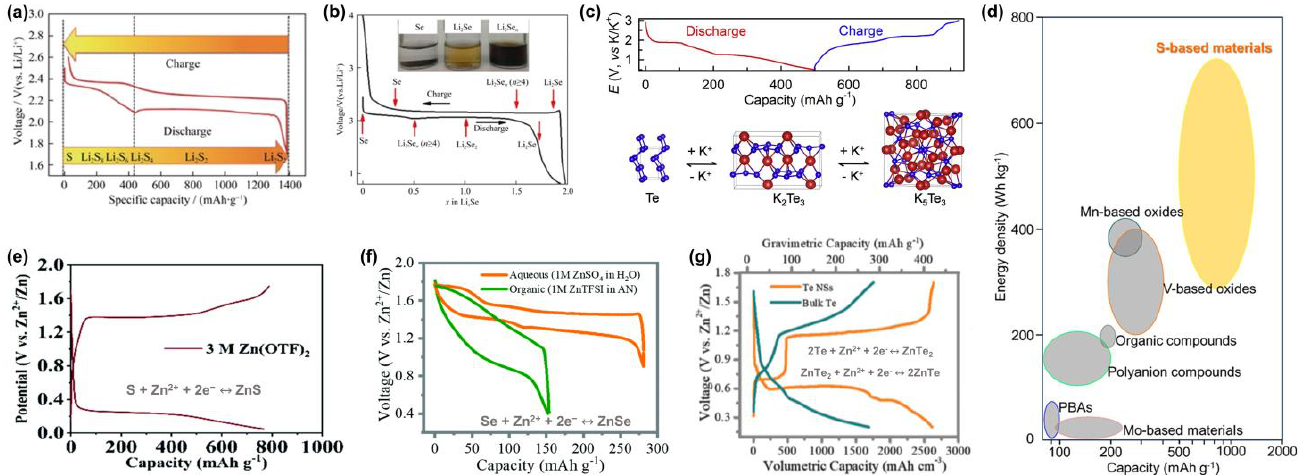
Figure 1. Voltage profiles and phase evolutions during charging/discharging of representative AMCBs: ( a ) Li-S batteries, ( b ) Li-Se batteries (reproduced with permission from Ref. [22]. Copyright 2017 The Nonferrous Metals Society of China and Springer-Verlag), and ( c ) K-Te batteries (reproduced with permission from Ref. [23]. Copyright 2020 Elsevier). ( d ) Comparison of capacities and energy densities of different cathodes in AZMBs (reproduced with permission from Ref. [61]. Copyright 2021, American Chemical Society). Voltage profiles during charging/discharging of representative AZCBs: ( e ) AZSBs (reproduced with permission from Ref. [64]. Copyright 2022, Royal Society of Chemistry), ( f ) AZSeBs (reproduced with permission from Ref. [65]. Copyright 2021, Royal Society of Chemistry), and ( g ) AZTeBs (reproduced with permission from Ref. [66]. Copyright 2020, WILEY-VCH).